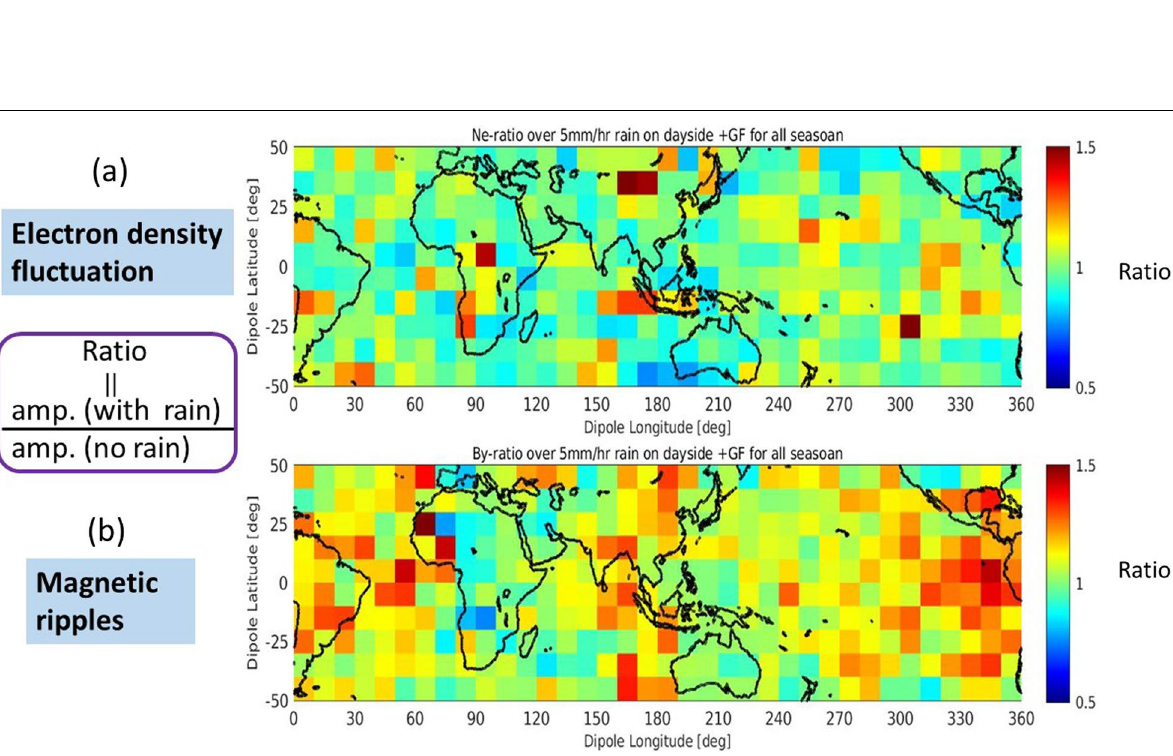
Fig. 6 a Ratio of averaged amplitude of electron density fluctuations in the cases of rainfall stronger than 5 mm/h to the cases of no rainfall. b Same as a but for magnetic ripples of By-component. GSMaP data are taken at the geodetic latitude and longitude where a geomagnetic line of force which pass the satellite location reach at 120 km altitudes in both hemispheres, i.e., P1 and P2 in Fig.